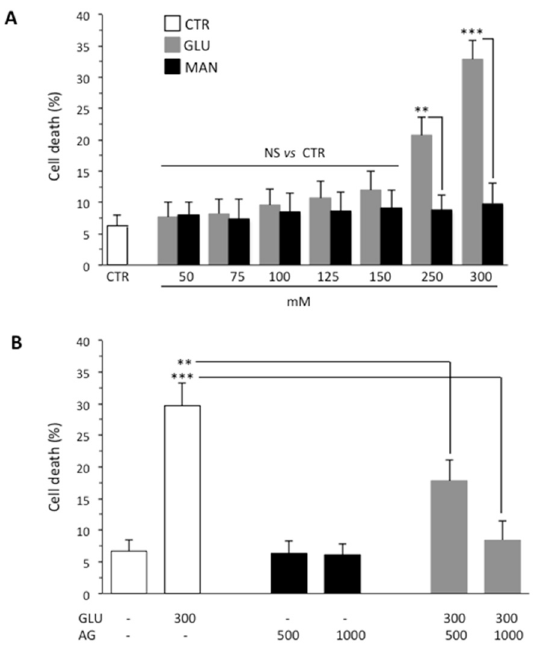
Figure 1. Flow cytometry analysis after staining with Calcein-AM (which is retained in the cytoplasm of live cells). ( A ) SH-SY5Y neuroblastoma cells were analyzed after treatment with increasing concentrations (0–300 mM) of GLU or MAN (used as an osmolarity control) for 48 h. Numbers represent the percentage of Calcein-negative cells (dead cells). Results obtained from three independent experiments are reported as means ± SD. ( B ) SH-SY5Y cells tested after treatment with 300 mM GLU or MAN alone or in combination with two different concentrations (500 and 1000 μ g/mL) of AG. Results obtained from four independent experiments are reported as means ± SD. ** is for p < 0.01, and *** is for p < 0.001.